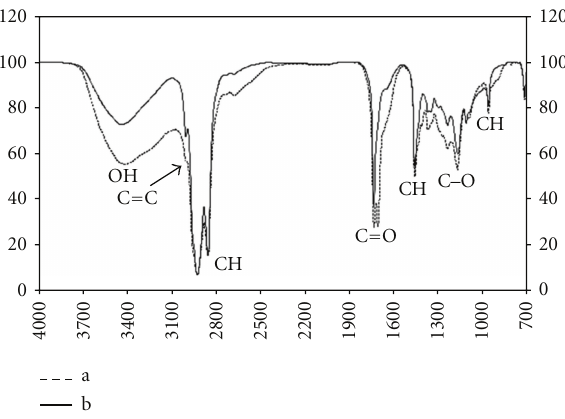
Figure 4: FTIR spectrum of the HYOOA (a) and OLHYOOD (b).